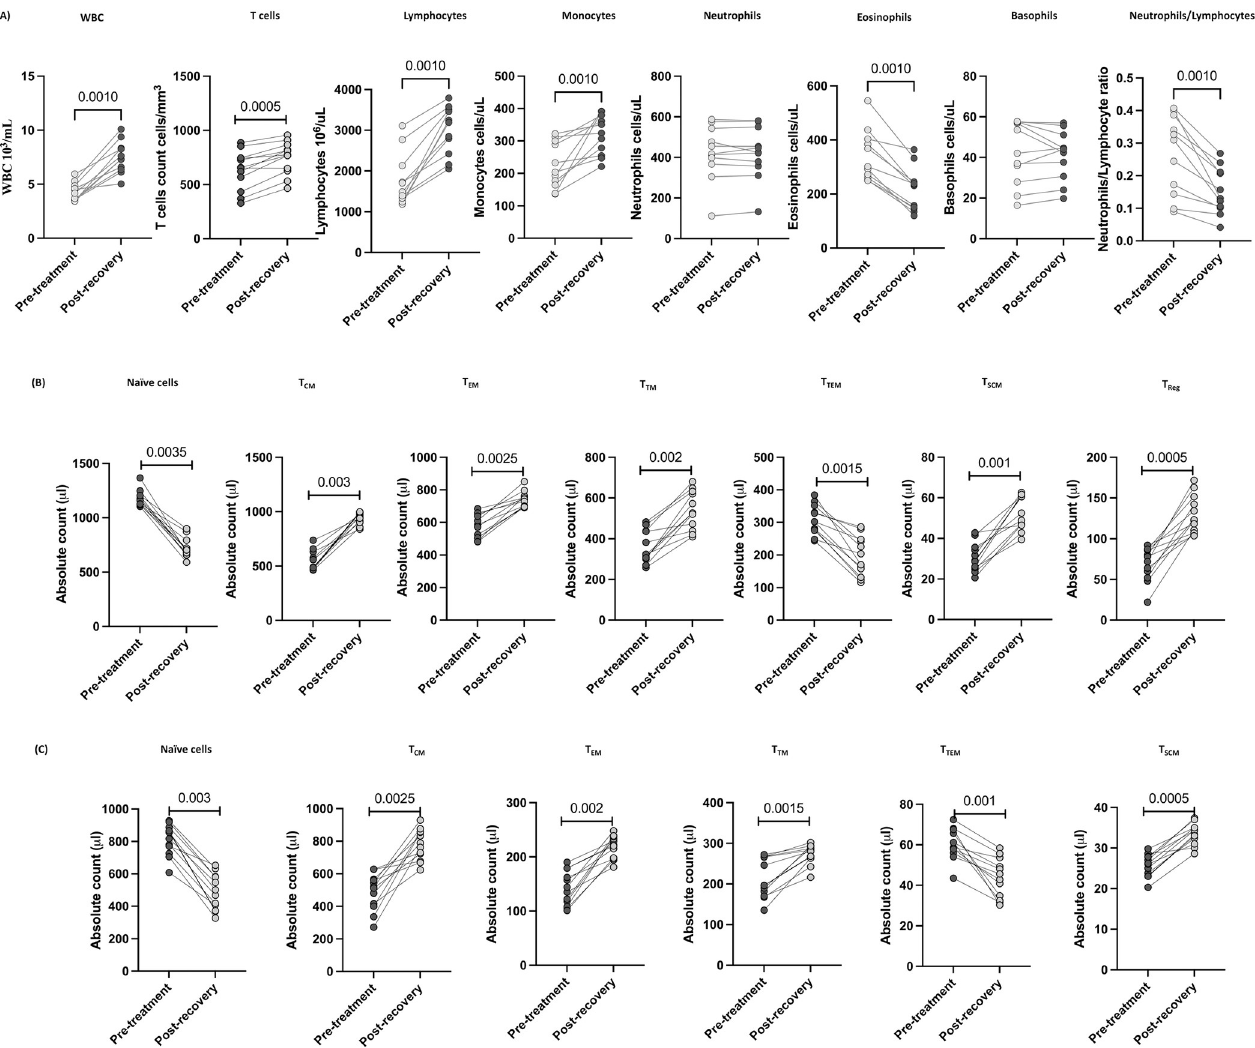
Fig 4. T cell subsets were altered post-recovery in MIS-C. (A) Absolute numbers of CD4 + T cell subsets in MIS-C children (n = 12) at pre-treatment and post-recovery were determined. (B) Absolute numbers of CD8 + T cell subsets in MIS-C children (n = 12) at pre-treatment and post-recovery were determined. p values were calculated using the Wilcoxon matched pair